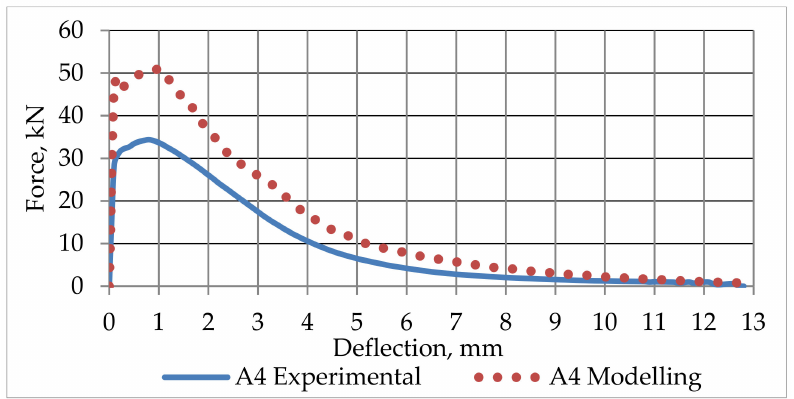
Figure 30. Experimental and modelling graphs for Group A4.